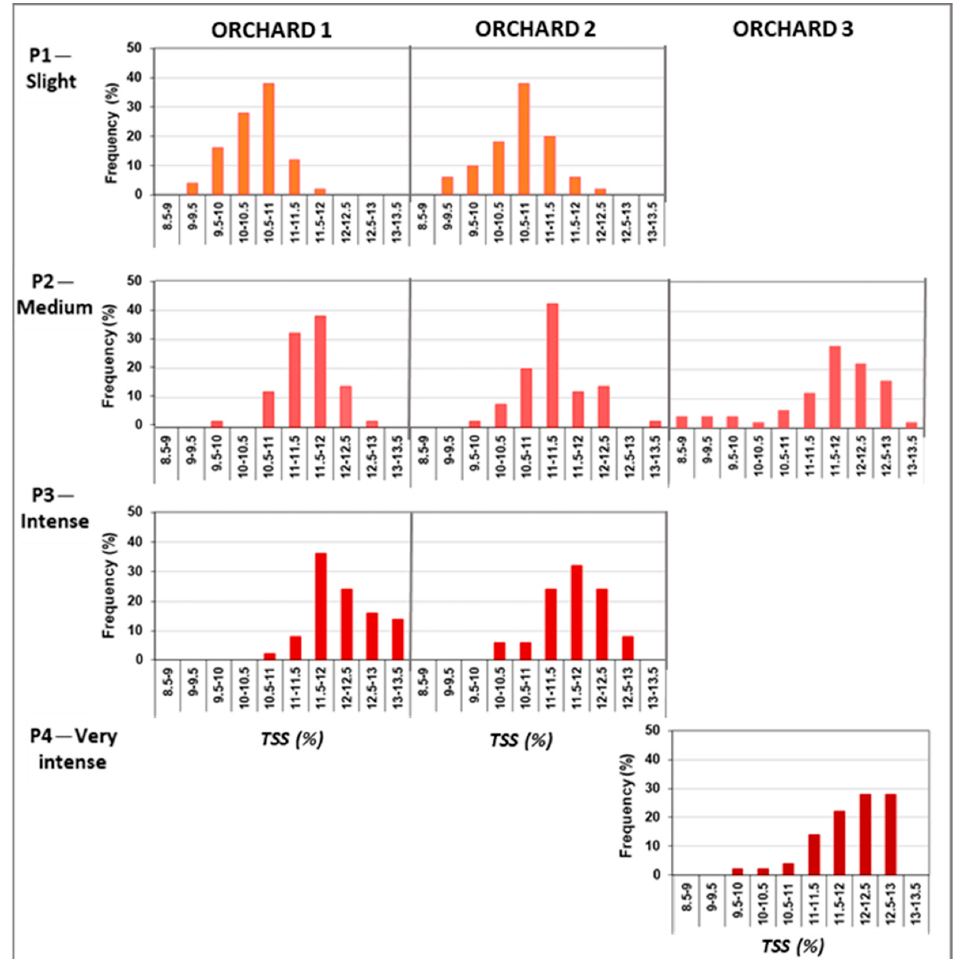
Figure 5. Frequency distribution of the total soluble solid content of ‘Sanguinelli’ blood oranges grouped according to rind pigmentation (P1—slight, P2—medium, P3—intense, P4—very intense). Each group of intensity for each orchard consisted of 50 individually analysed fruits.